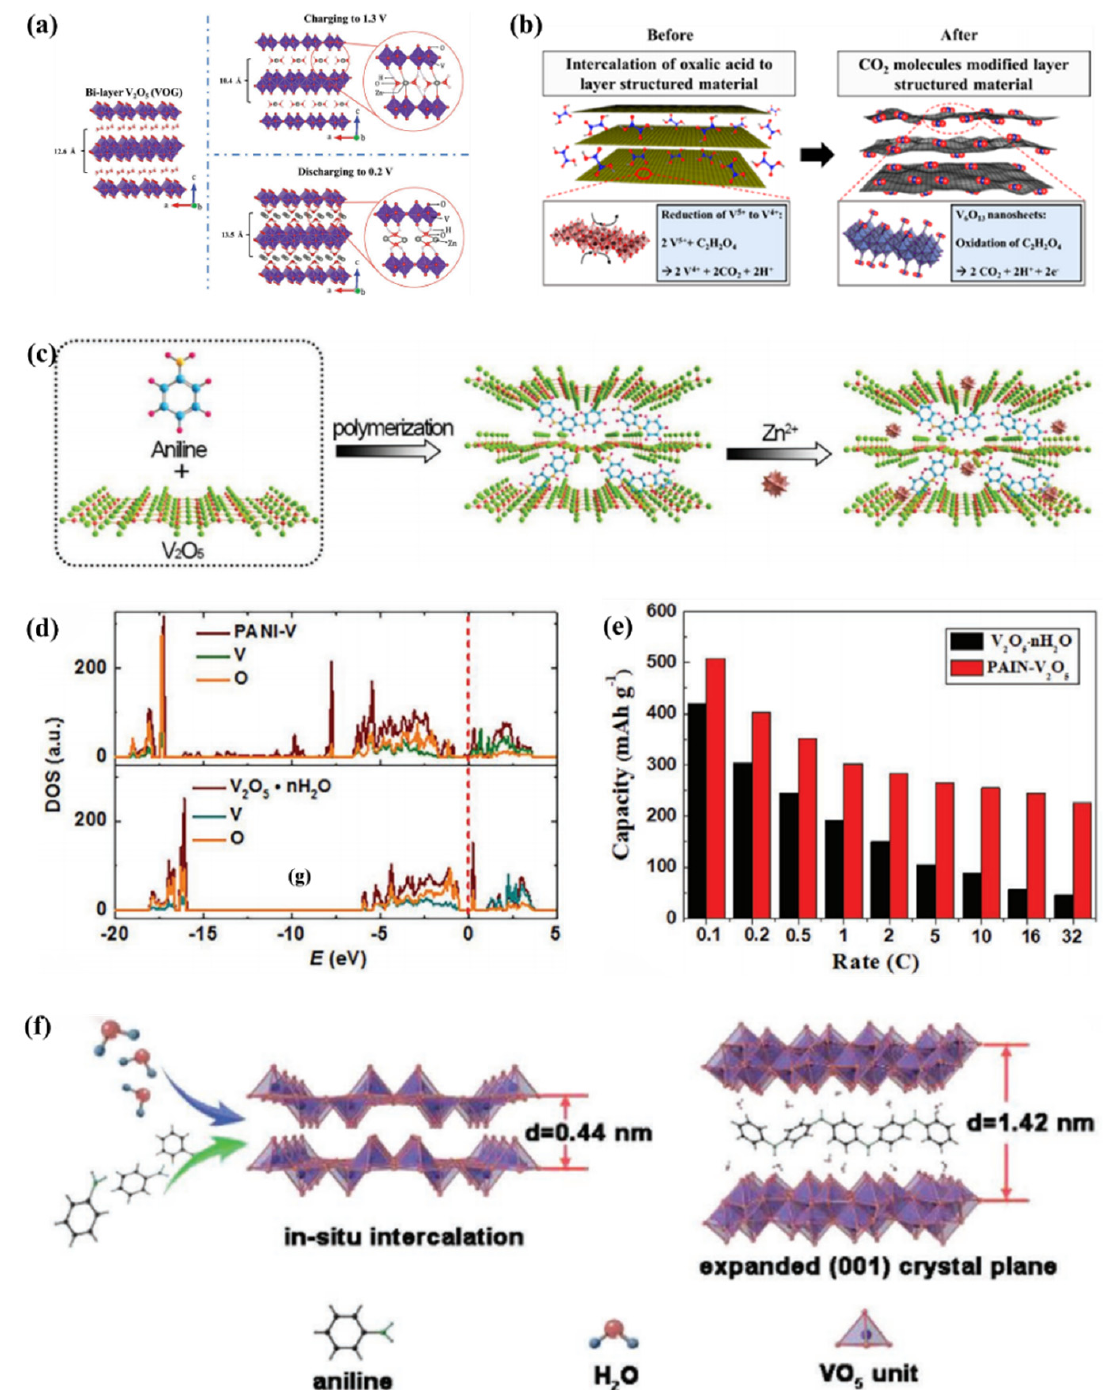
Figure 5. ( a ) The crystal structure of the original VOG and the VOG after charge and discharge (Ref. [18]). ( b ) The structure diagram of V 6 O 13 before and after CO 2 molecule embedding (Ref. [58]). ( c ) Preparation of PANI − V superlattice material (Ref. [59]). ( d ) DOS of V 2 O 5 ·nH 2 O and PANI − V (Ref. [59]). ( e ) Rate capacity of PANI − V (Ref. [59]). ( f ) The schematic diagram of PANI − intercalated V 2 O 5 (Ref. [60]).